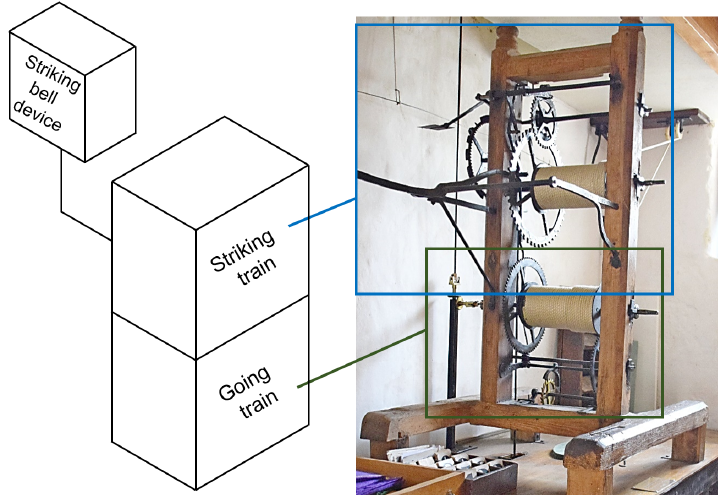
Figure 8. Structure of the Metfield clock (N5) (Simon, 2019).